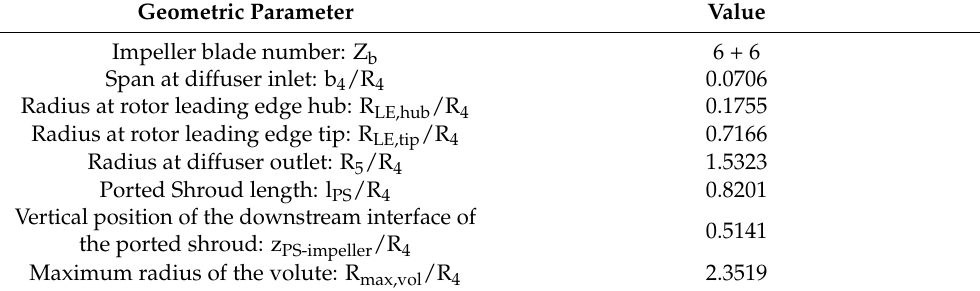
Table 1. Geometrical non-dimensional data of the reference compressor.